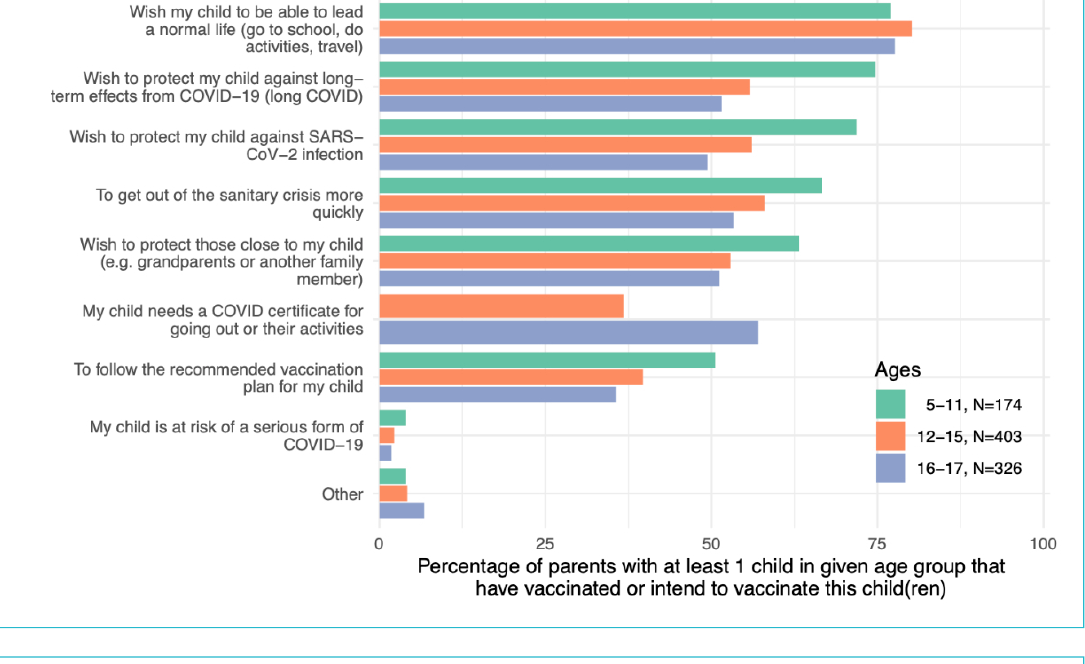
Figure 3: Reasons for deciding not to vaccinate children. Parents of children in the given age groups were asked their reasons for not wanting to vaccinate or not being sure about vaccinating their children. Multiple choices were